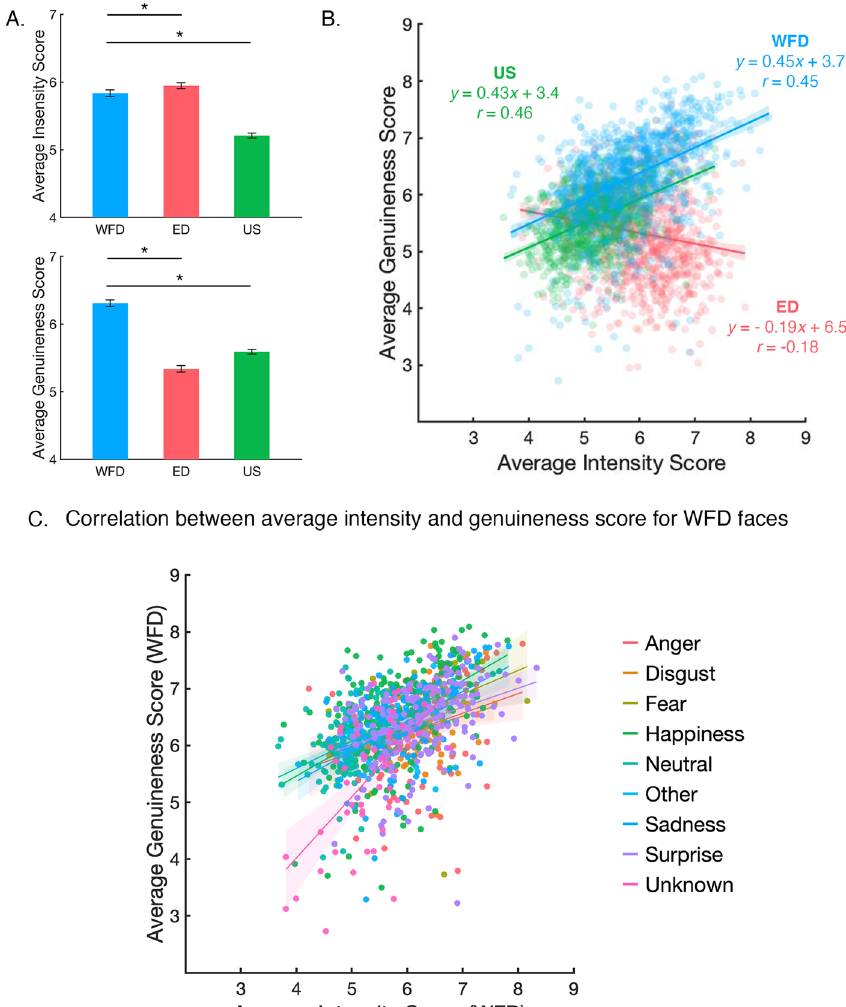
Figure 5. ( A ) Average expression intensity (top) and genuineness (bottom) scores as a function of the three databases (WFD, ED, and US). Error bars are 95% CI . Lines with asterisks indicate significant pairwise differences ( p < 0.001). ( B ) Average intensity scores were highly correlated with genuineness scores for images in the WFD (blue markers), ED (red markers), and US (green markers) databases. The corresponding solid lines are the result of the best fitting linear regression of the form y = mx + b . ( C ) The relationship between genuineness and intensity for the WFD redrawn to examine the influence of modal categorization. Color reflects the emotion most often used by human participants to categorize the image. The solid lines are the result of the best fitting linear regression, as in ( B ), and their length marks the data range. Thus, any clustering of colored dots would indicate that particular emotions are perceived as more genuine and/or intense than others. However, this is not the case, all colors are dispersed, and we observe positive relationships between genuineness and intensity for every emotional category. That said, this plot does not take into account categorical spread and specificity